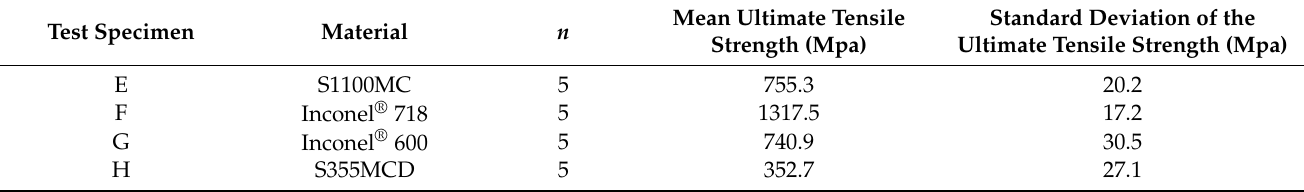
Table 6. Tensile strength of the control specimens ( n = number of